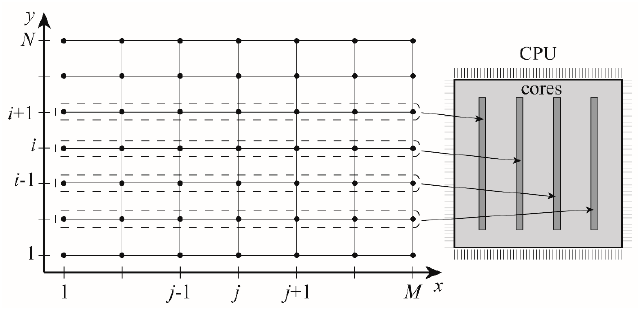
Figure 3. Schematic of the parallelization strategy resulting from the domain decomposition.